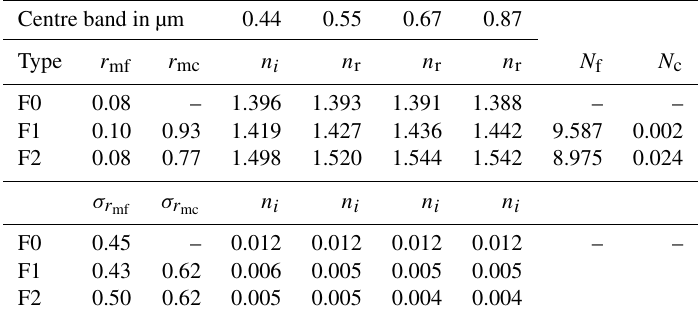
Table 2. List of aerosol properties used for the simulations. The parameters r mf and r mc are the median fine- and coarse-mode radii expressed in µm. Their respective standard deviations are σ r and σ r . The parameters n r and n i are the real and imaginary part of the refractive index mc mf in the indicated bands. N f and N c are the fine- and coarse-mode particle concentration in number of particles per cm 3 .